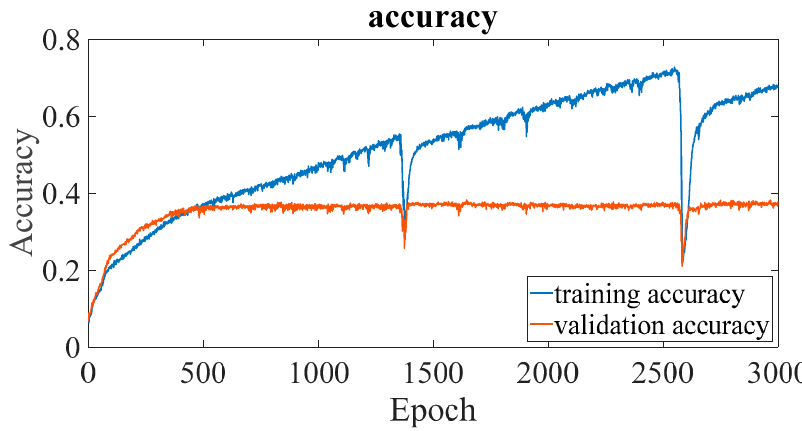
Figure 5. Training and validation accuracy of Figure 4 (adapted from [10]).